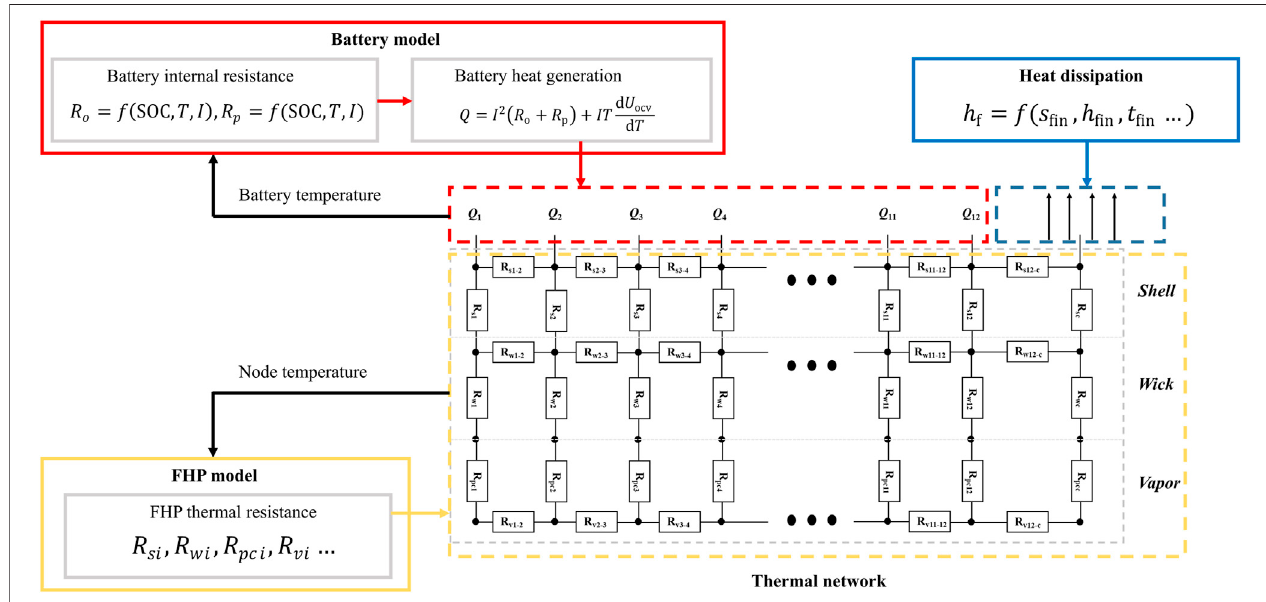
FIGURE 3 | Coupling method of the battery model and the FHP model.